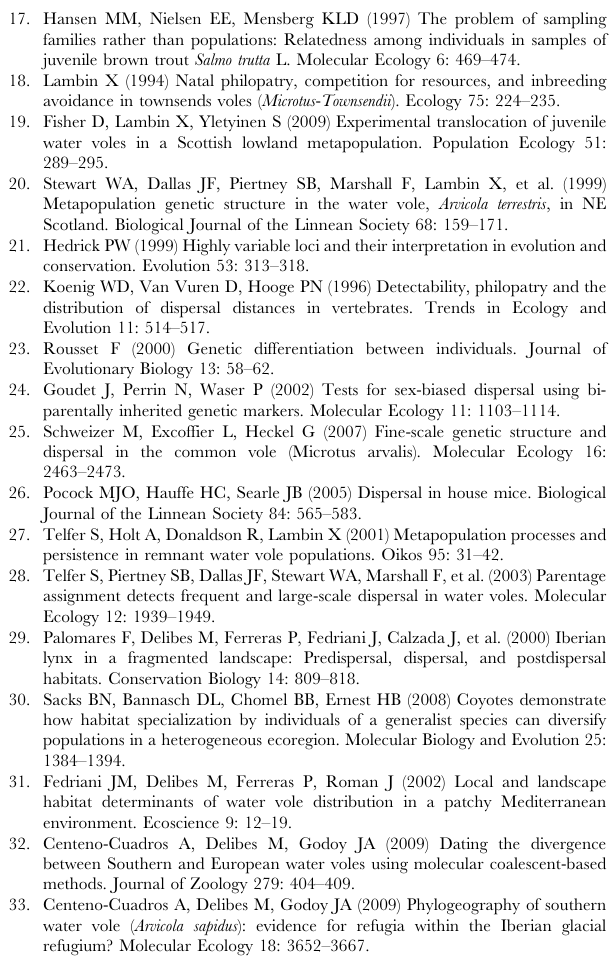
Table S2 Haplotypes of Control Region and their geographical distribution all over the Natural Region of Don˜ana (a) . Control Region nucleotide diversity by sampling area and overall study system (b) . Sample size ( N ), number of segregating sites ( S ), nucleotide diversity ( p ), number of haplotypes ( h ), haplotype diversity ( H ) and mean number of nucleotide differences ( k ) are reported. Standard Deviations are given in parenthesis ( SD